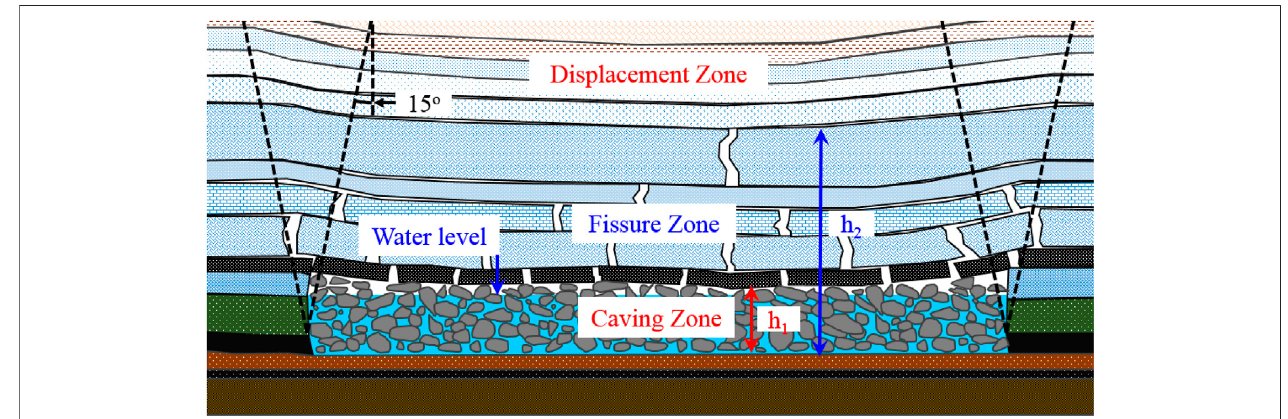
FIGURE 3 | Diagram for “ three zones ” of overlaying rock